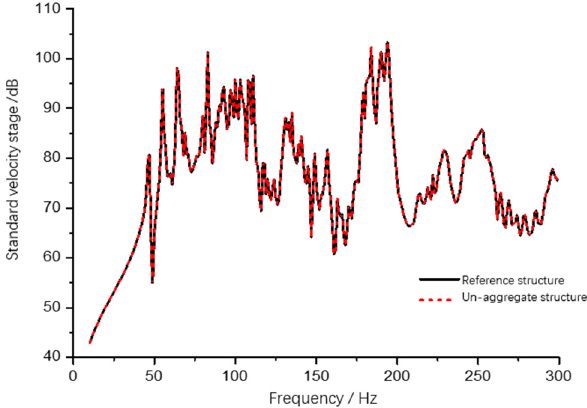
Figure 4: Mean square velocity of cabin deck B.